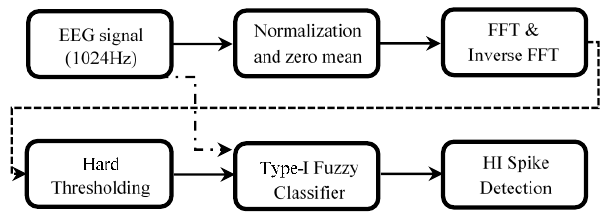
Figure 4. Schematic of micro-scale HI spike transient detector.